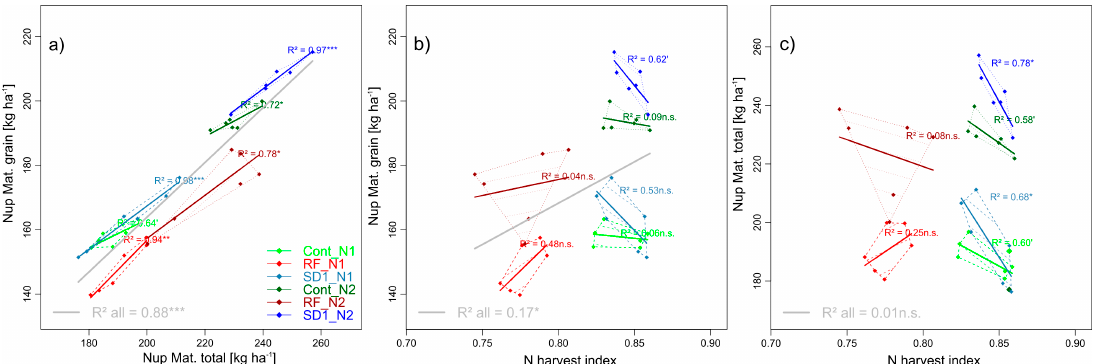
Figure 7. Pairwise trait relationships in trait complex h : Nup of grain at maturity (GNup) in relation to its two multiplicative components total Nup at maturity (Nup Mat. total, ( a )) and the N harvest index (NHI, unitless, ( b )) as well as the relationship of total Nup at maturity with NHI ( c ). N levels are distinguished by line types and color intensities (N1: Dashed lines and light colors, N2: Dotted lines and dark colors). Dashed and dotted lines delimit the bivariate data range covered by cultivars within MP × N-combinations. Colored regression lines indicate the linear trait relationships within MP × N-combinations and gray lines the regression line for the whole trial, calculated across the included data of reduced fungicide (RF), control (Cont) and sowing date 1 (SD1). Gray lines are only drawn for significant relationships ( p < 0.05). P -values of regression slopes are indicated as p < 0.01 (***), p < 0.01(**), p < 0.05 (*) and p < 0.1 (´).